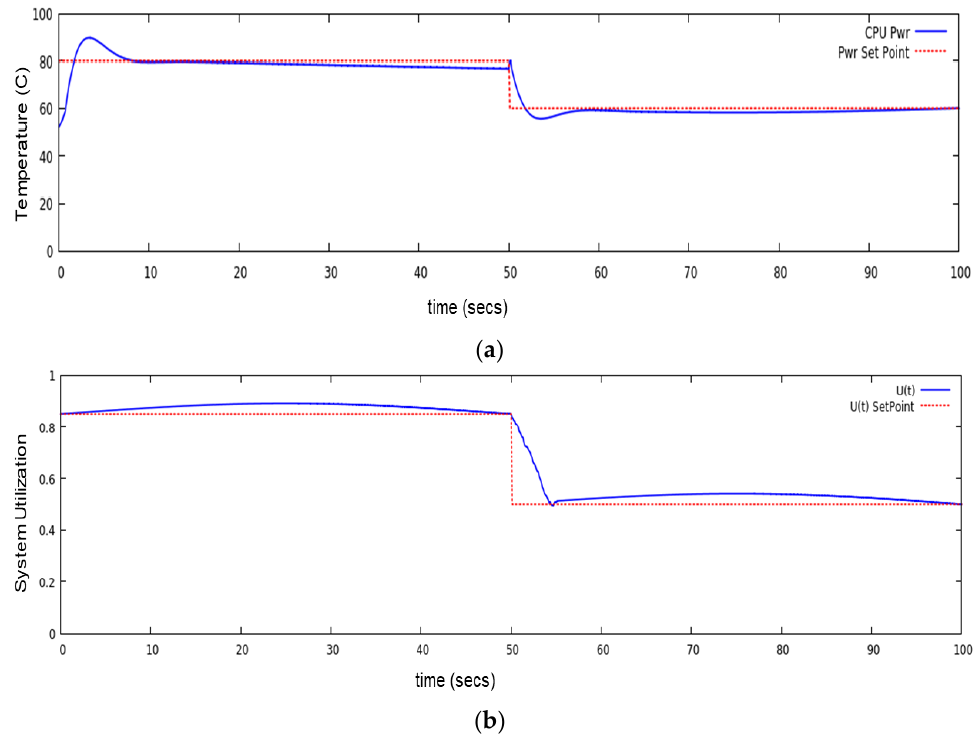
Figure 8. ( a ): Power Performance, ( b ): System Utilization.